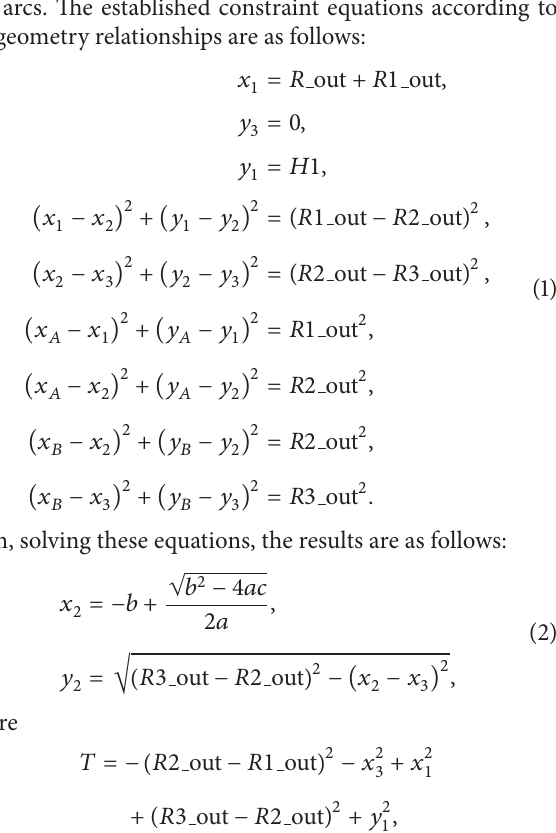
Take the parameterization of D-shape cross section as an example. The D-shape cross section contains one straight line and five arcs. Only the upper half of the cross section is considered since the lower half has the same structure. The detailed geometric elements of the upper half are shown in Figure 5. There are one straight line and three arcs in Figure 5, which are tangential to each other. Although there are 18 parameters to describe the geometry in Figure 5, they are not independent of each other due to the tangency among